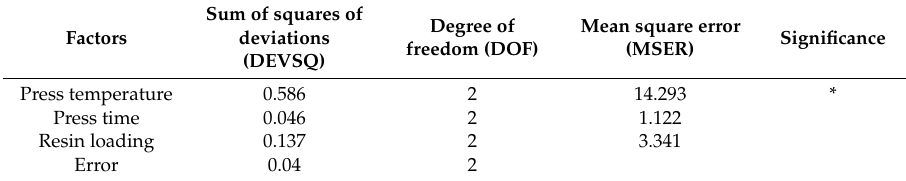
Table 6. The variance analysis of the orthogonal experiments on dry shear